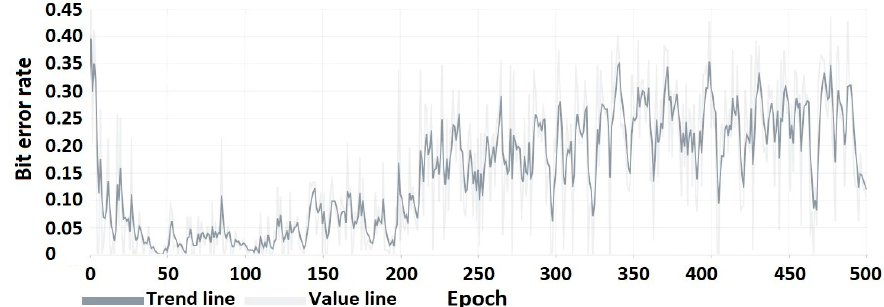
Figure 10. BER of the hidden message (watermark in the form of binary string).